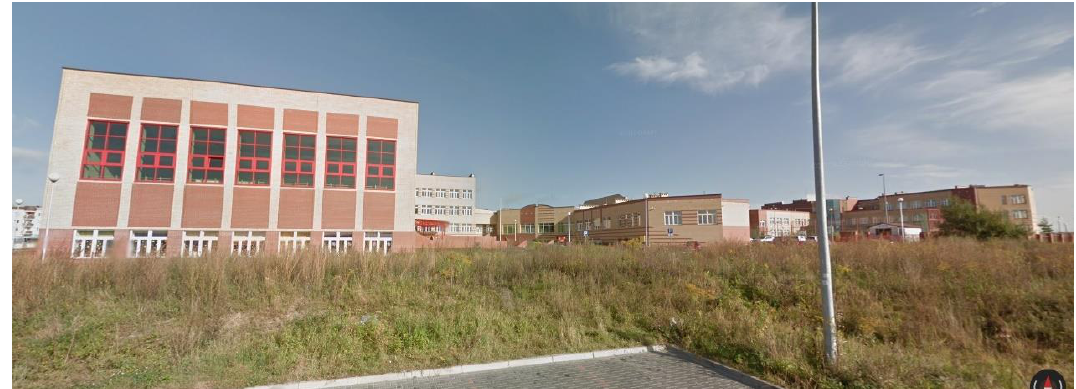
Figure 4. View of the building elevation from the south.